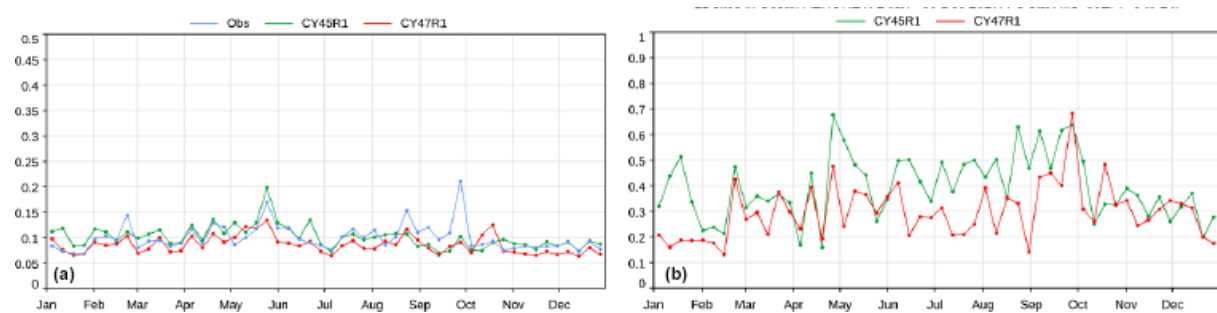
Figure 14. (a) Observed and simulated AOD (averaged weekly) in 2017 over a selection of 14 AERONET stations more representative of